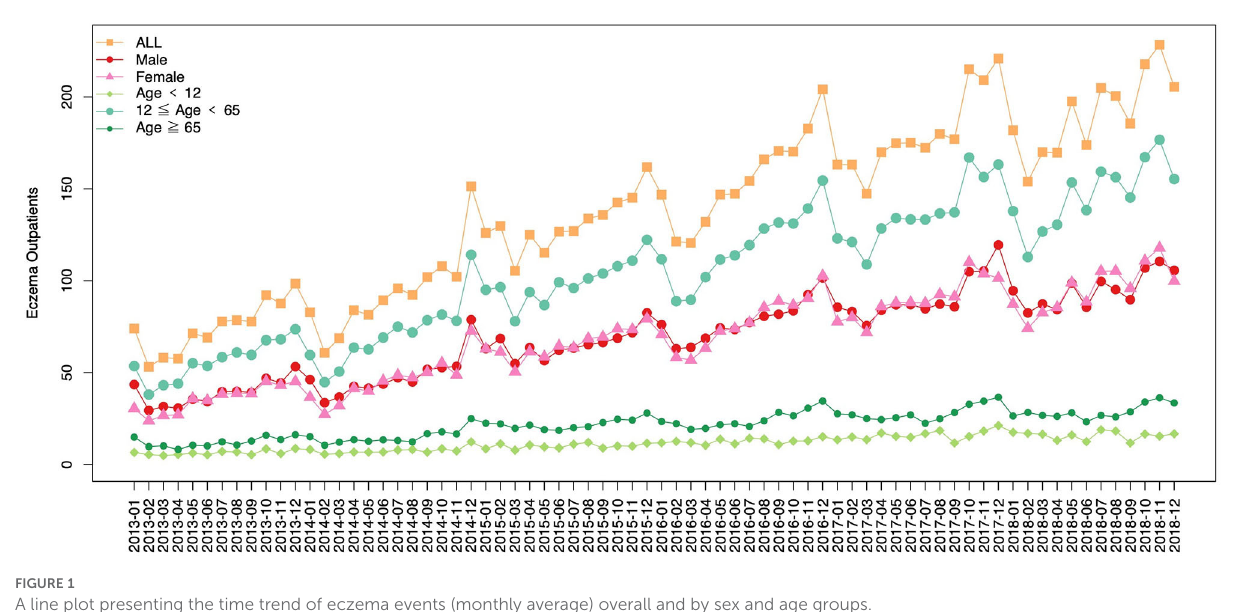
FIGURE1 A line plot presenting the time trend of eczema events (monthly average) overall and by sex and age groups.